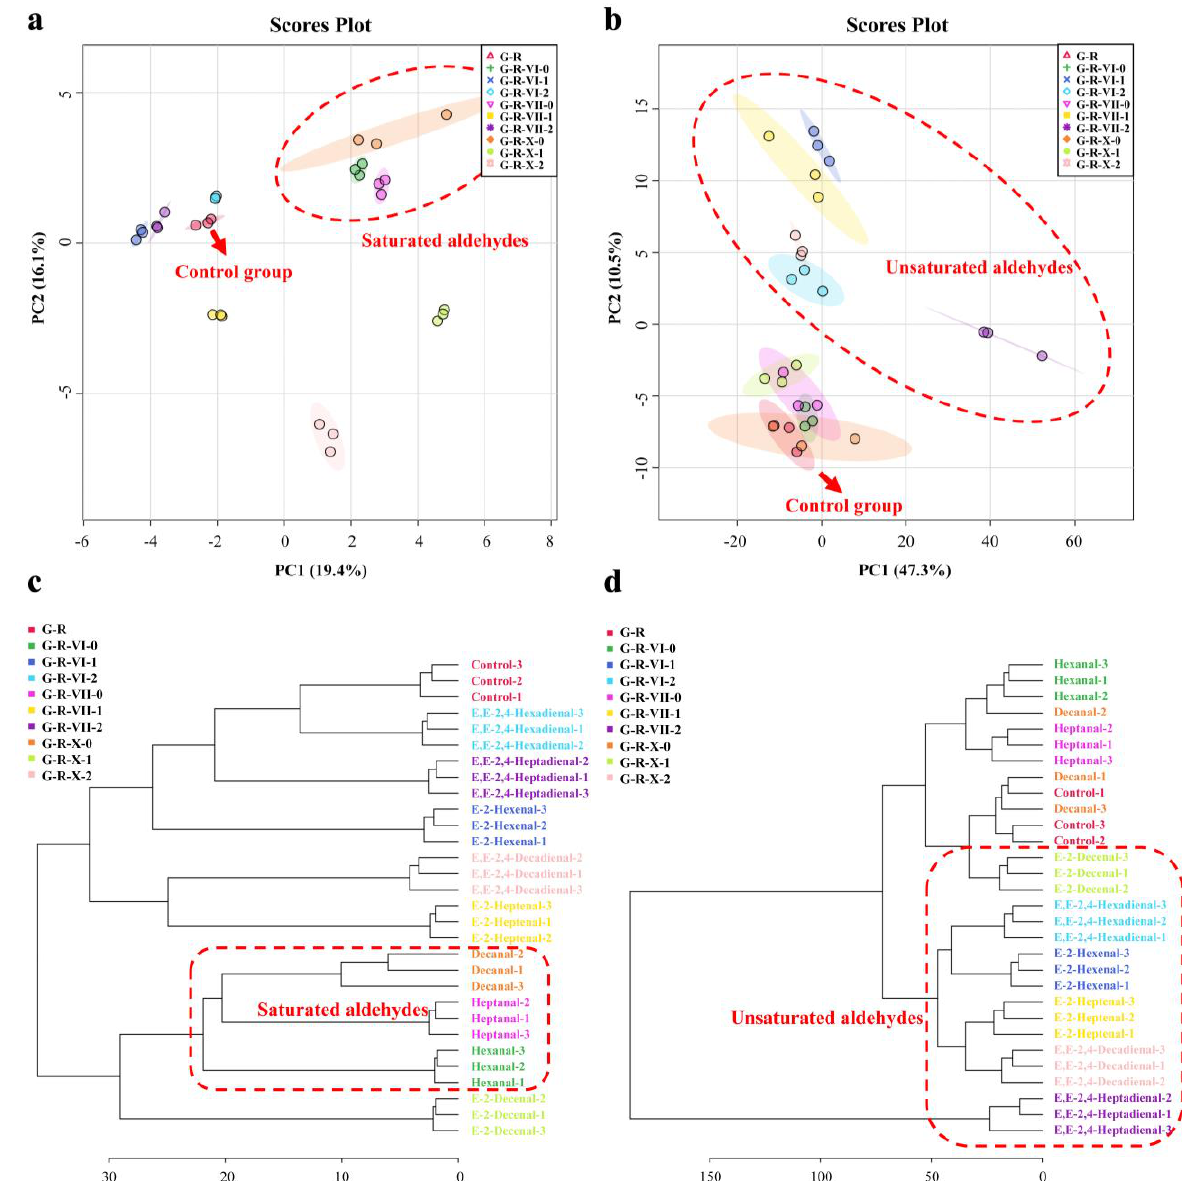
Figure 3. PCA score plots and HCA of the MRPs produced by the MR systems with different aliphatic aldehydes. Sample clustering based on GC-MS and UPLC-MS results by ( a,b ) PCA and ( c,d ) HCA.